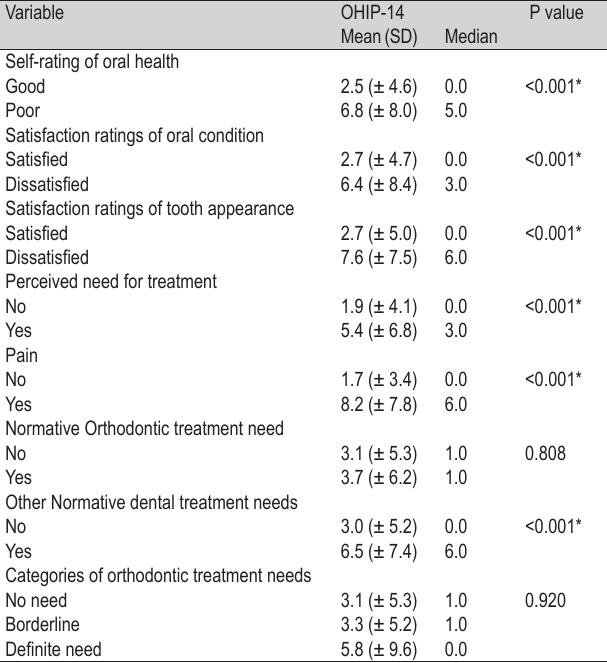
Table 2 - The discriminant and construct validity of